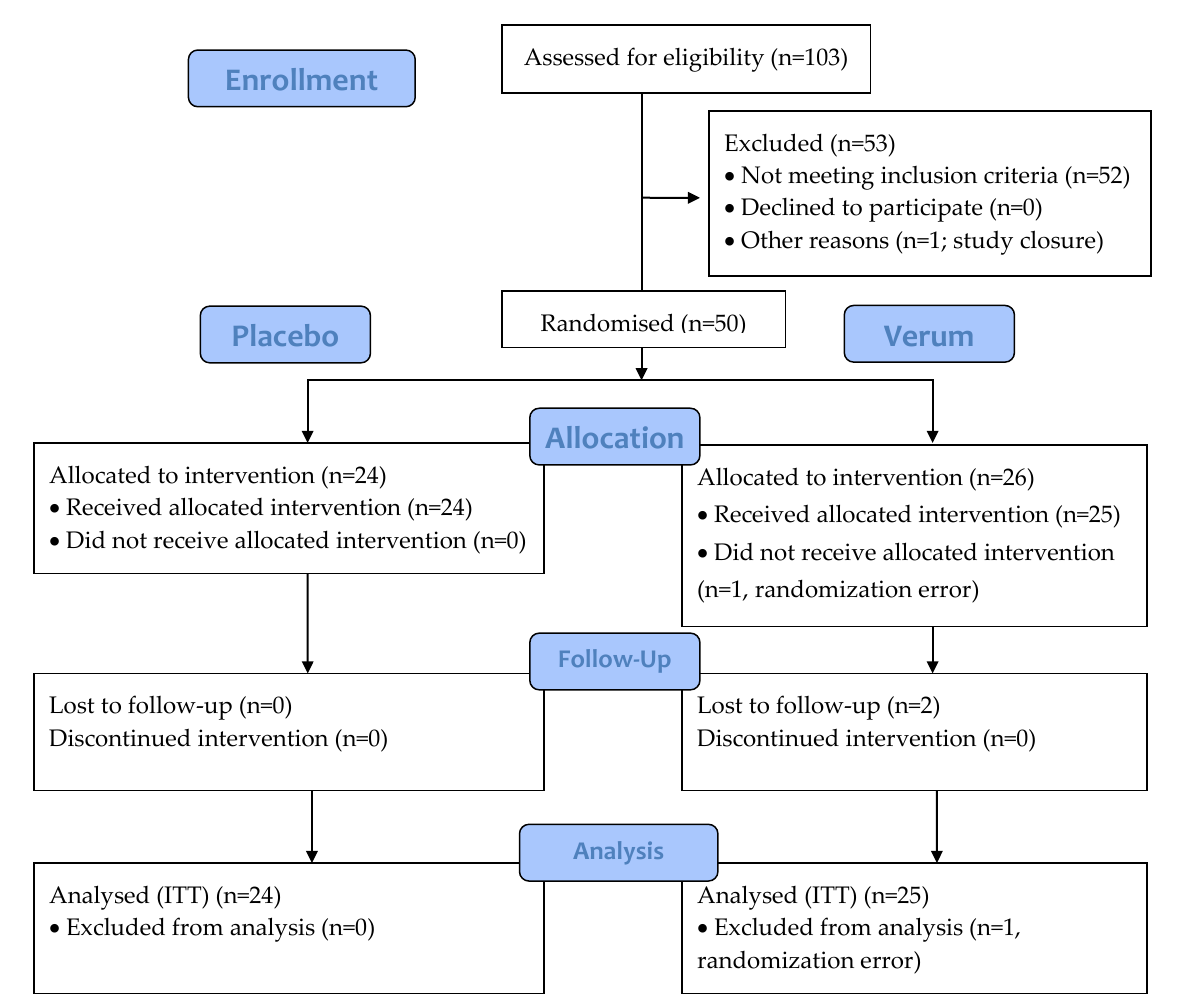
Figure 2. CONSORT flow diagram of the 21-day intervention study of triple-blind, randomised, and placebo-controlled design. Placebo: maltodextrin; Verum: 10 10 CFU Lactobacillus acidophilus La-14 and Lacticaseibacillus rhamnosus HN001. CONSORT, consolidated standards of reporting trials; ITT,